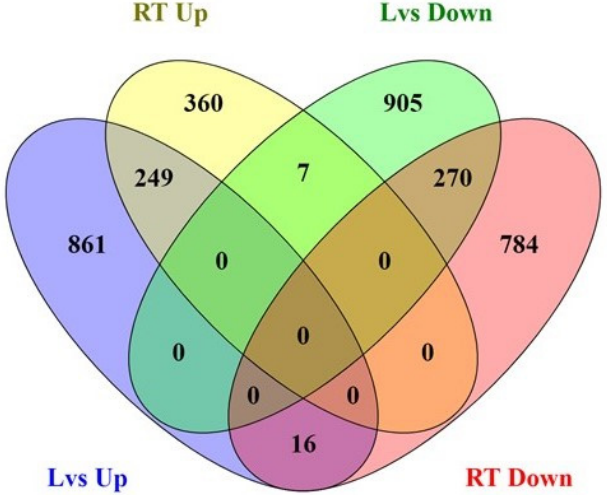
Figure 2. The Venn diagram shows the number of differentially expressed genes (DEGs) in each group and the overlaps between groups. (Lvs Up—Upregulated in leaf; RT Up—Upregulated in root; Lvs Down—Downregulated in leaf and RT Down—Downregulated in root). The number in the circle represents the total number of DEGs, and the overlap represents the DEGs in